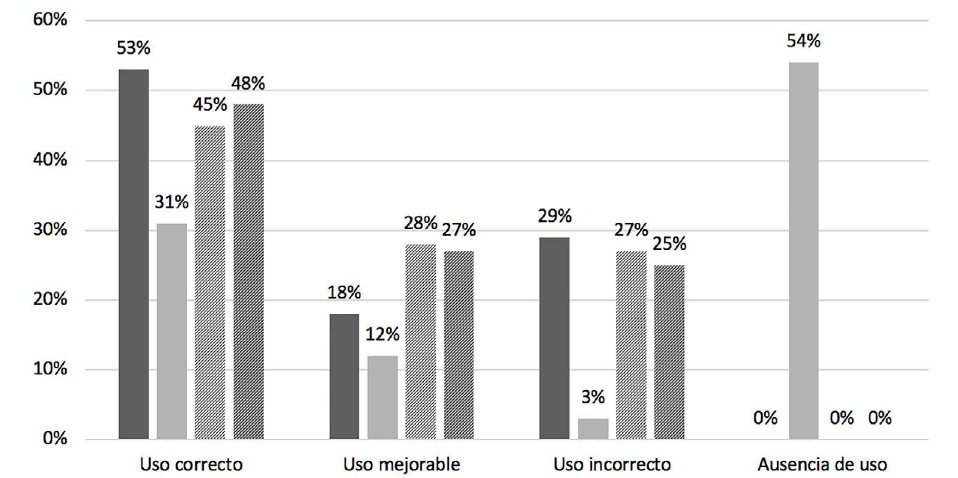
Figure 5. Adequacy of the visual language to the theme in the original photographs produced by future teachers. Source: